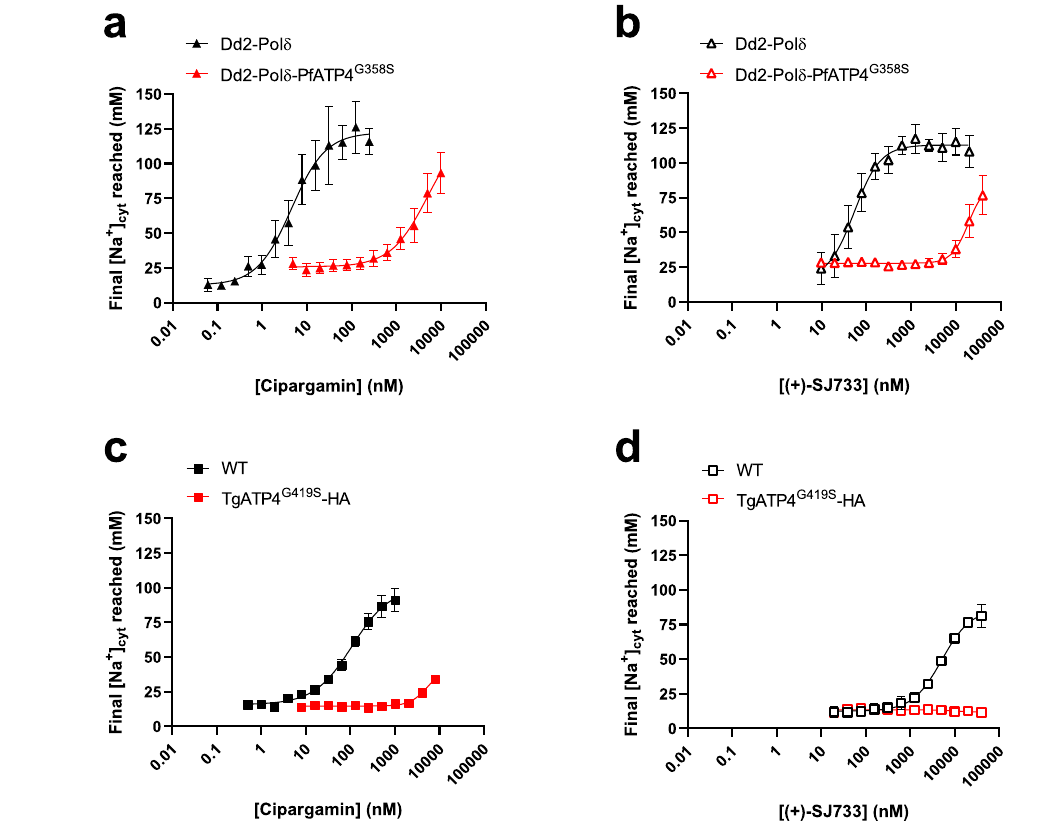
numberofindependentexperiments(performedondifferentdays):5( a ,Dd2-Pol δ ;